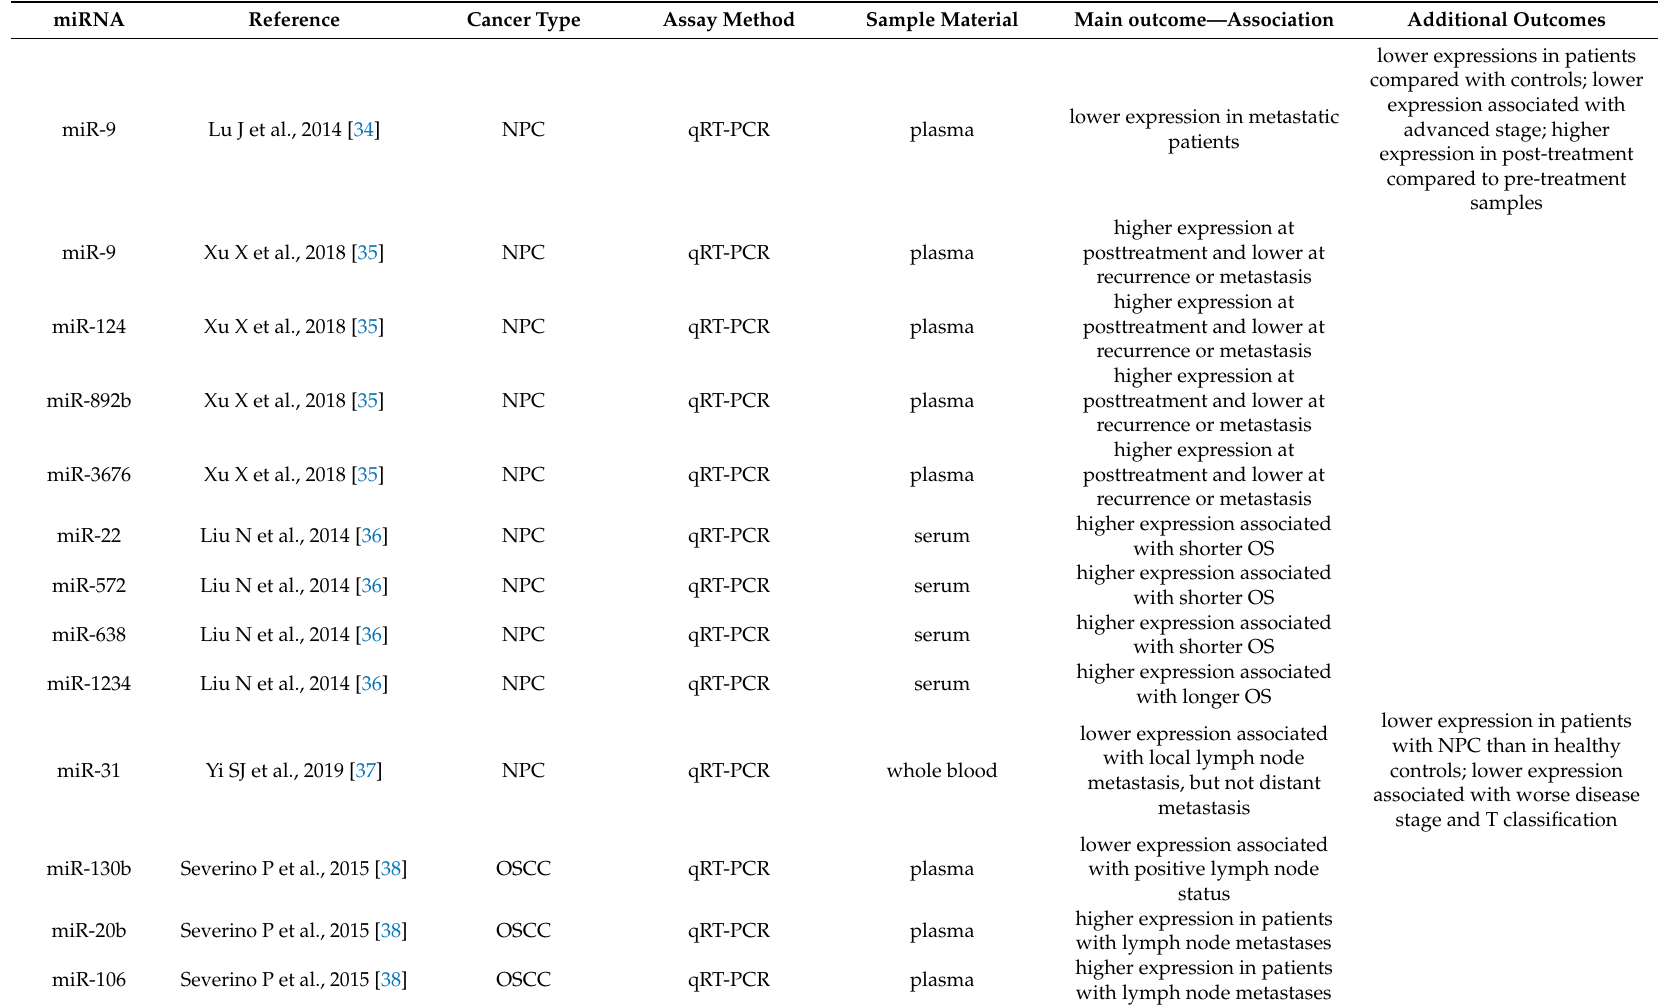
Table 1. miRNAs implied as biomarkers in head and neck squamous cell carcinoma